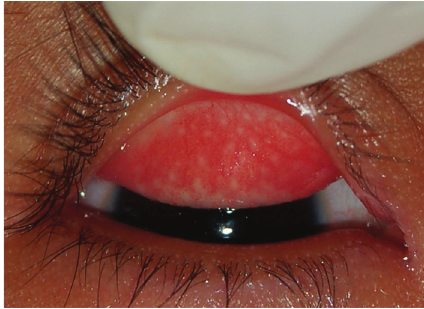
Figure 6: Inflammatory trachoma with Follicular trachoma (TI + TF stage). Figure courtesy of Hollman Miller, Vaup´es, Colombia.